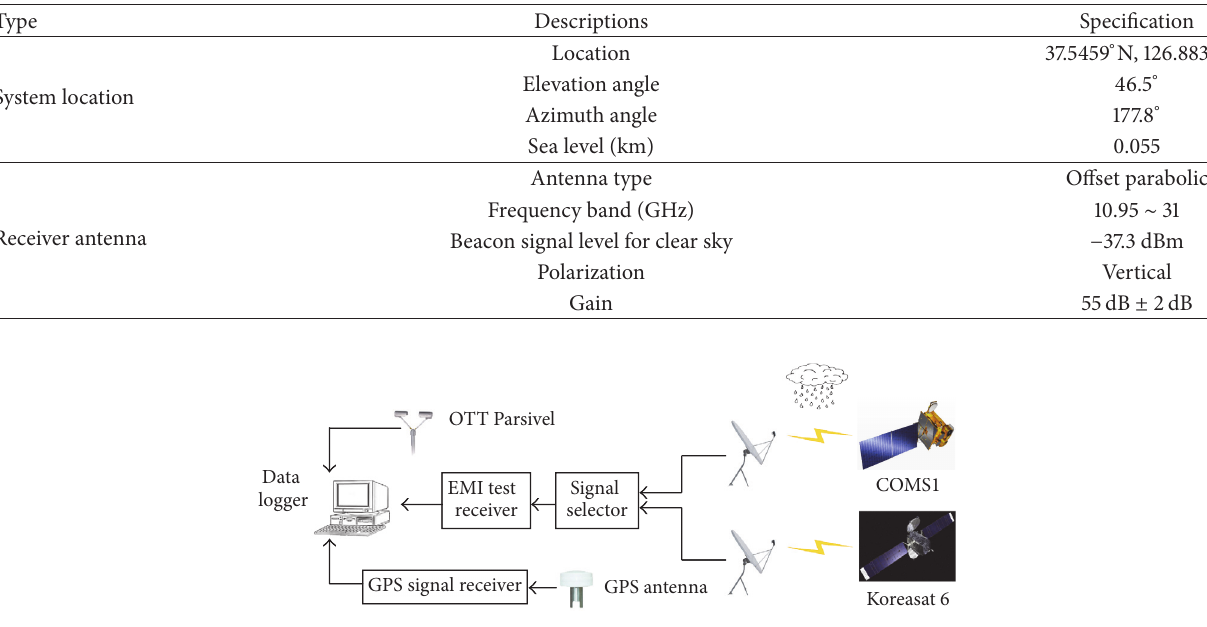
Table 3: Specifications of the 19.8 GHz link for COMS1 satellite link [19].